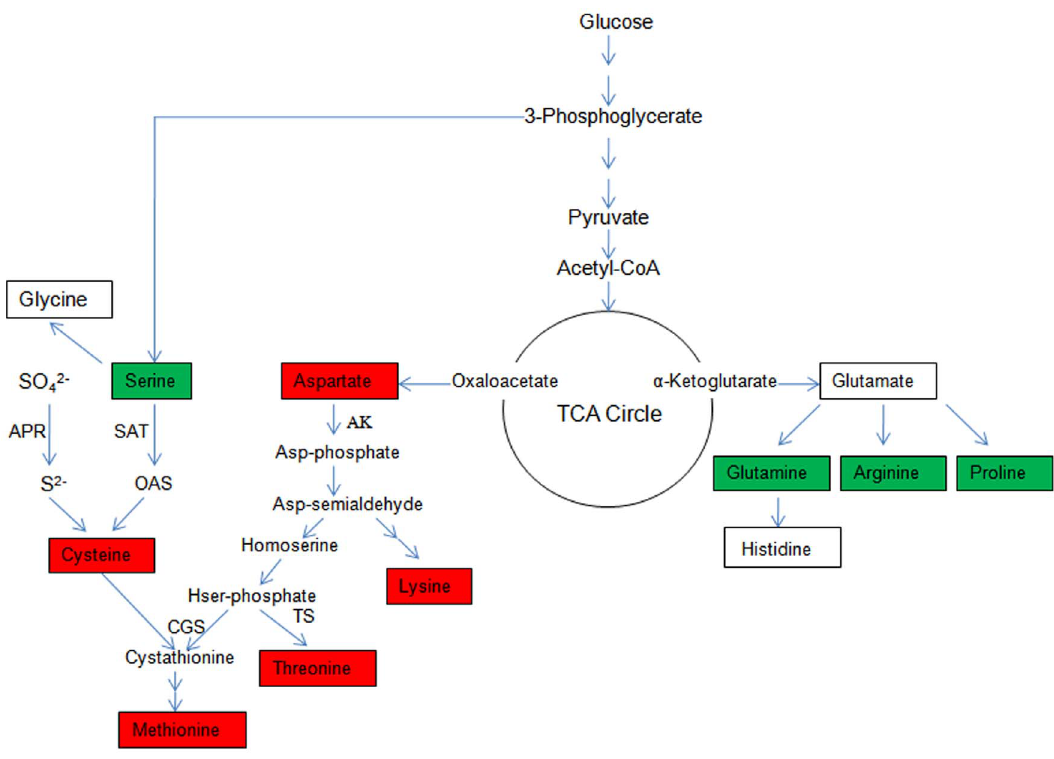
Figure 8. Amino acid metabolic pathways and its integration into the TCA cycle. Red indicates increased amino acids; Green indicates decreased amino acids.